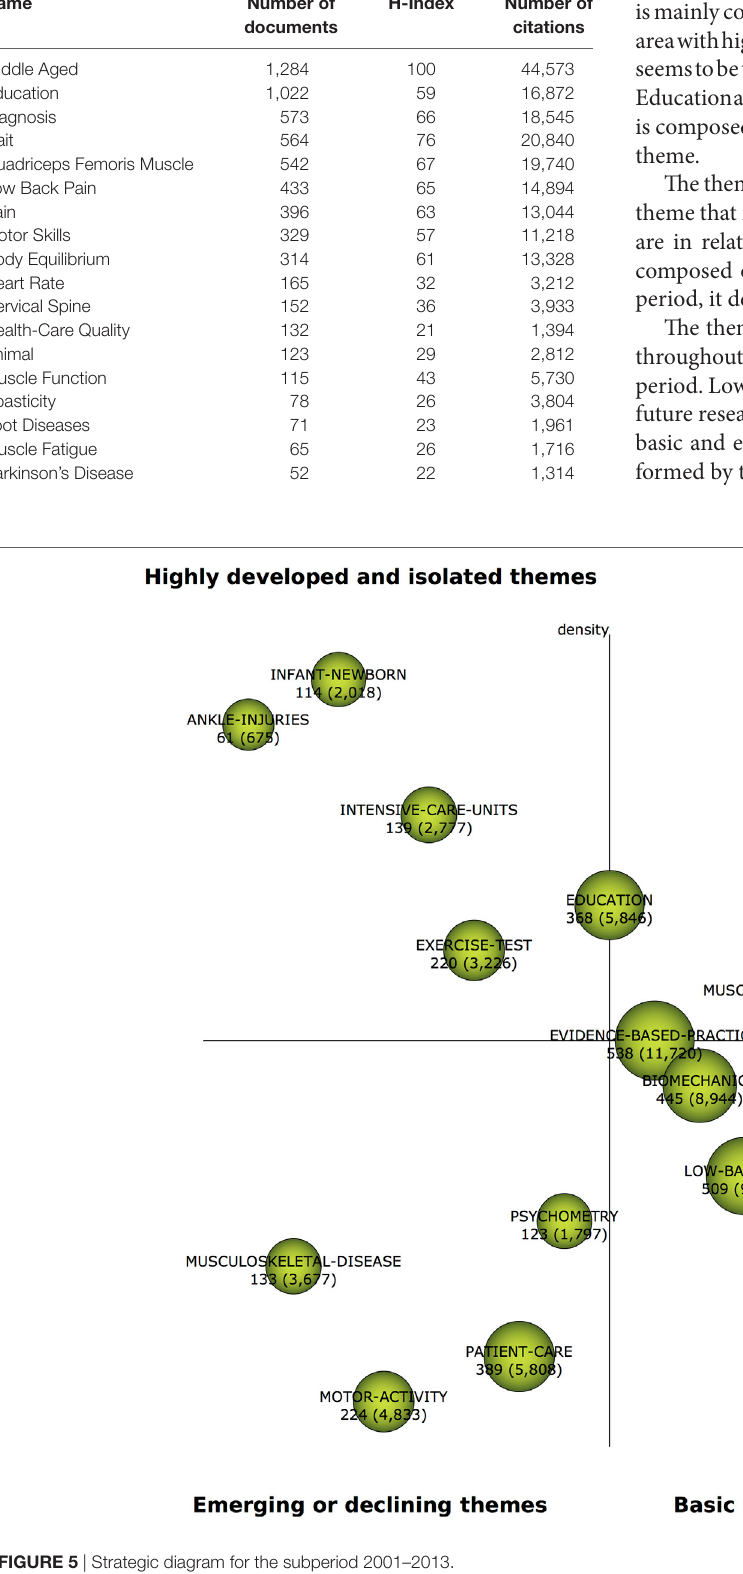
FigUre 5 | Strategic diagram for the subperiod 2001–2013.